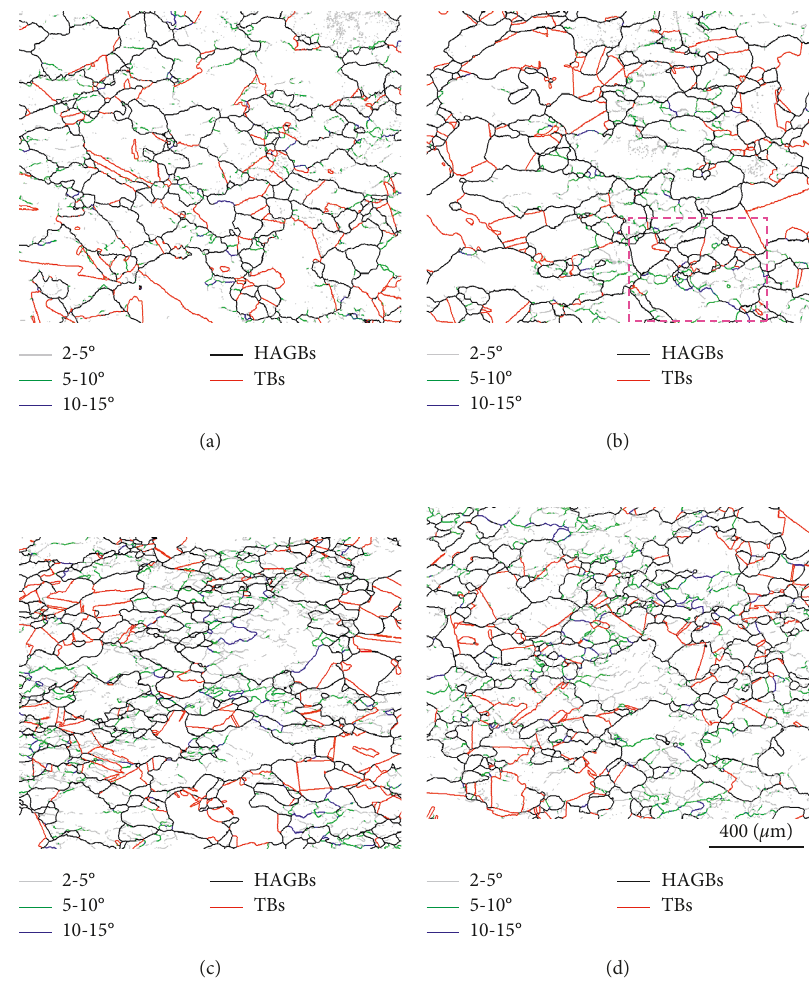
Figure 3: Microstructure of 18Mn18Cr0.6N steel compressed at 1150 ° C and 10 − 4 · s − 1 to different strains. (a) 0.2, (b) 0.4, (c) 0.6, and (d)